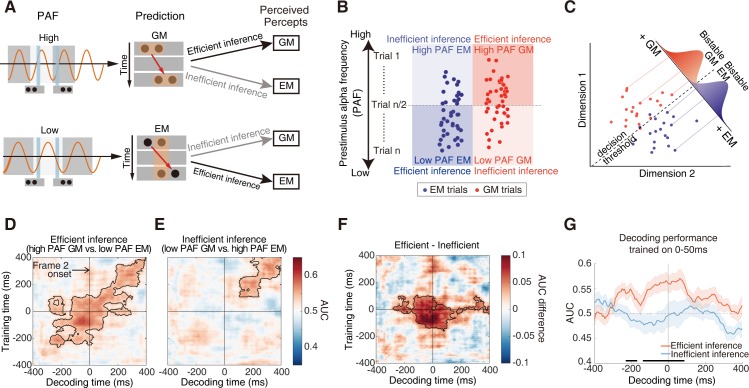
Hypothesis and results of decoding results of the EEG data.(A) Hypothesis on the efficient versus inefficient inference. Upper: predictions towards the GM percepts will be generated based on higher PAFs since it is more possible for the two frames to fall in different alpha cycles. Lower: predictions towards the EM percepts will be generated based on lower PAFs since it is more possible for the two frames to fall within the same alpha cycle. Conjointly considering the specific prediction and the forthcoming bottom-up inputs, perceptual inference towards one specific percept will be made. The perceptual inference is defined as efficient if it is consistent with the perceived percept and inefficient if inconsistent. (B) Post hoc trial categorization procedure for the decoding analysis. All the bistable trials were first sorted based on their PAF values. The bistable trials with a PAF higher than the PAF of the median trial (trial n/2, n = the total number of bistable trials) were considered as the high PAF trials, while the bistable trials with a PAF lower than the PAF of the trial n/2 were considered as the lower PAF trials. Therefore, conjointly based on the PAF (high versus low) and the perceptual outcome (EM versus GM), the bistable trials were categorized into the following four types: (1) the high PAF GM trials, (2) the low PAF EM trials, (3) the low PAF GM trials, and (4) the high PAF EM trials. The former two types of trials were assigned to the efficient inference condition since the prior perceptual inference based on the PAFs was consistent with the subsequently perceived percept, while the latter two types of trials were assigned to the inefficient inference condition since the perceptual inference was inconsistent with the perceptual outcome. (C) A hypothetical 2D activation space for the EEG signals representing the bistable EM and GM percepts. Activation patterns for each percept are projected onto a discriminant axis, which differentiates the two percepts. A decision boundary placed along the axis allows for classification between the bistable EM and GM percepts. The overlap of the Gaussian distributions reflects “decision noise.” More distant representations produce less noise and result in higher decoding accuracy. (D) Temporal generalization matrices for the efficient inference condition. (E) Temporal generalization matrices for the inefficient inference condition. (F) Temporal generalization matrices for the differential contrast between the efficient versus inefficient conditions. Columns in the images are the time points the classifier was trained, and rows are the time points the classifier was tested. Color values indicate decoding accuracy in terms of AUC (D, E) or AUC difference (F). The contour with the black line indicates the significant cluster, p < 0.05. (G) Decoding performance over time with training time 0–50 ms after the onset of frame 2. For the purpose of visualization, the figure shows a row in the temporal generalization matrix in (F) at the training time at which we see a significant cluster of generalization difference before the onset of frame 2. Significant generalization time points are indicated with horizontal black bars (p < 0.05). Time 0 indicates the onset of frame 2. Shaded regions indicate ±1 SEM. Underlying data available at https://osf.io/tze94/. AUC, area under the receiver operator characteristic; EEG, electroencephalography; EM, element motion; GM, group motion; PAF, prestimulus alpha frequency; SEM, standard error of the mean.